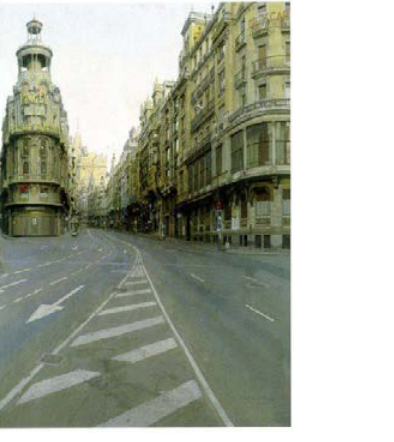
canvas – 81.28x91.44c m